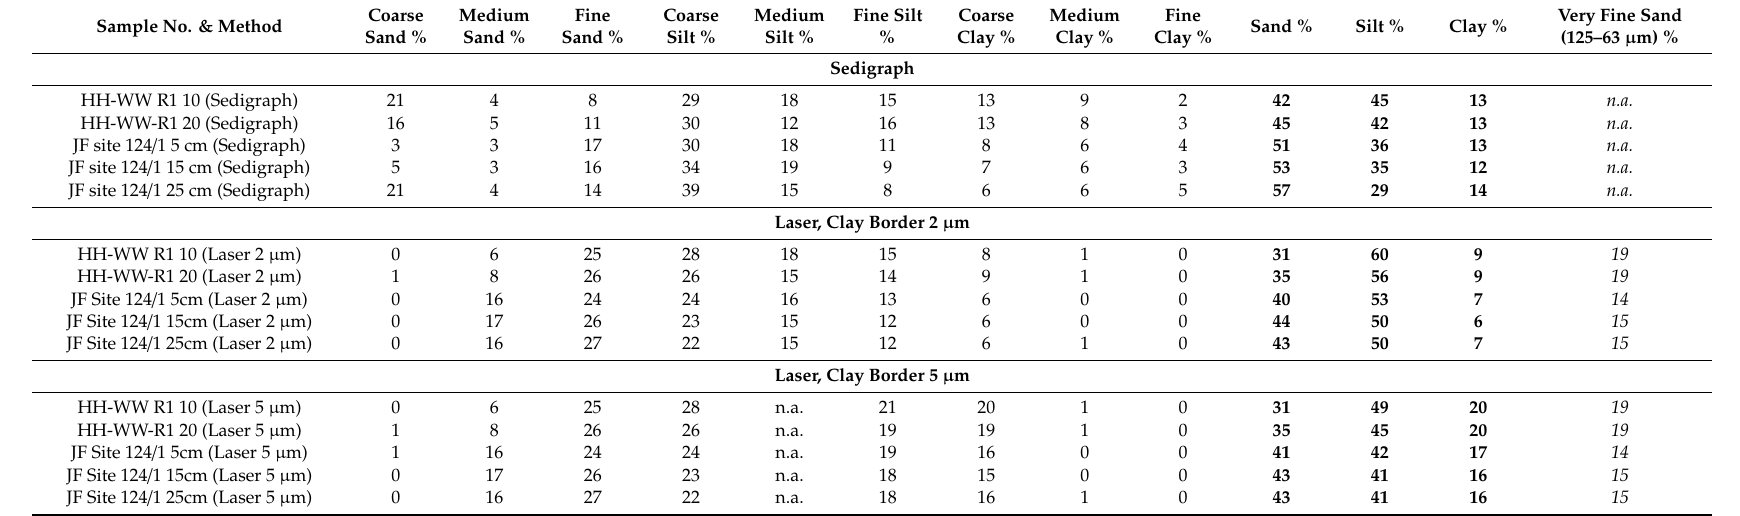
Table A9. Comparison of results of particle size analysis of ruin soil samples by wet sieving and Sedigraph with the Malvern Mastersizer 3000 laser device, applying clay-silt borders of 2 and 5 µ m for laser